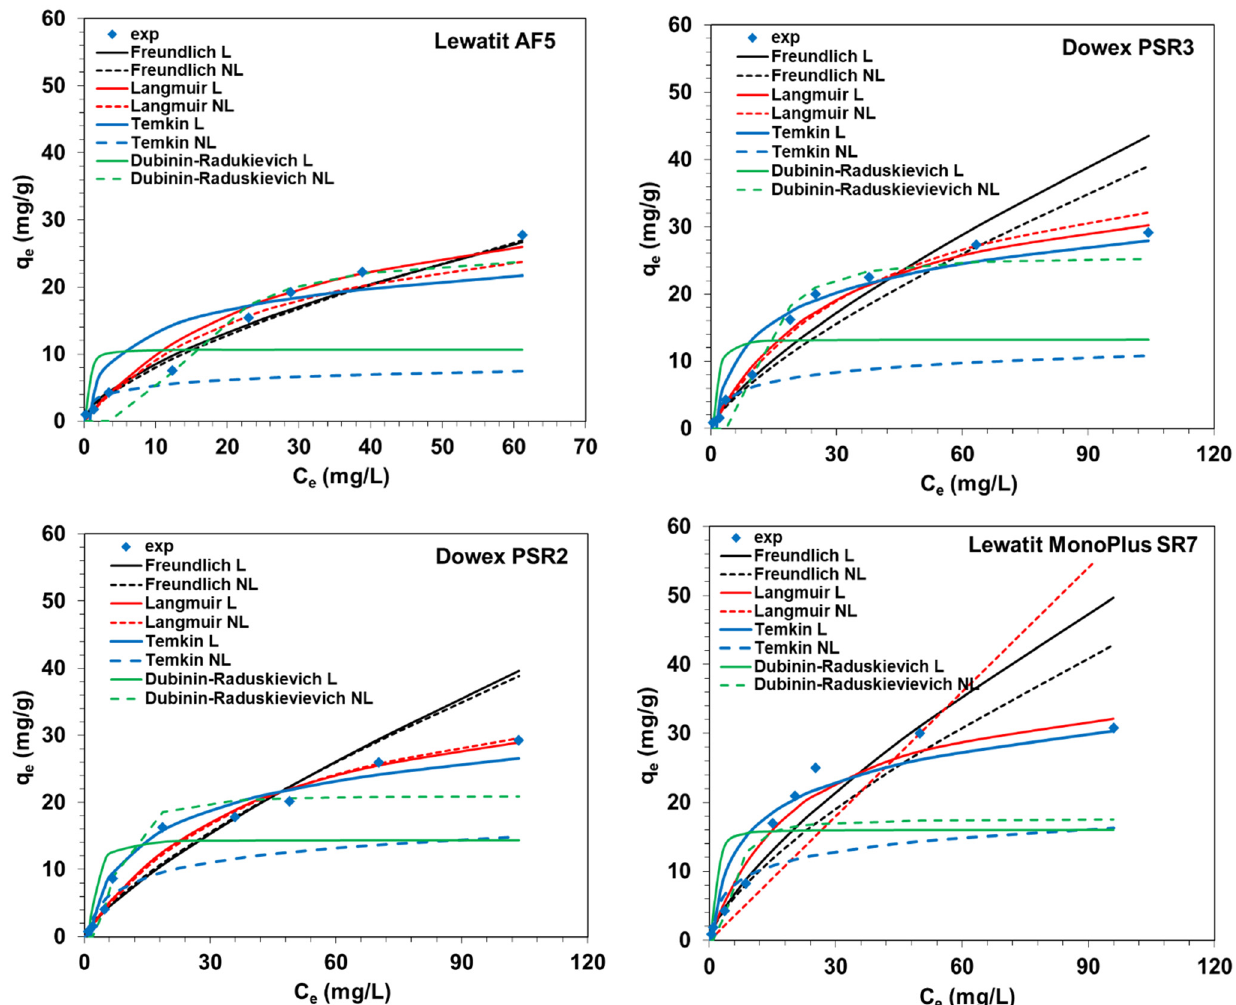
Figure 10. Examples of the isotherms fitting to the experimental data for the sorption of V(V) ions on SR7, PSR2, PSR3, and AF5 sorbents using L (linear) and NL (non-linear) regressions. Table 5. Characterization of the isotherm models and the parameters obtained for the V(V) ions sorption on the S984, A830, A400TL, SR7, PSR2, PSR3, and AF5 sorbents.